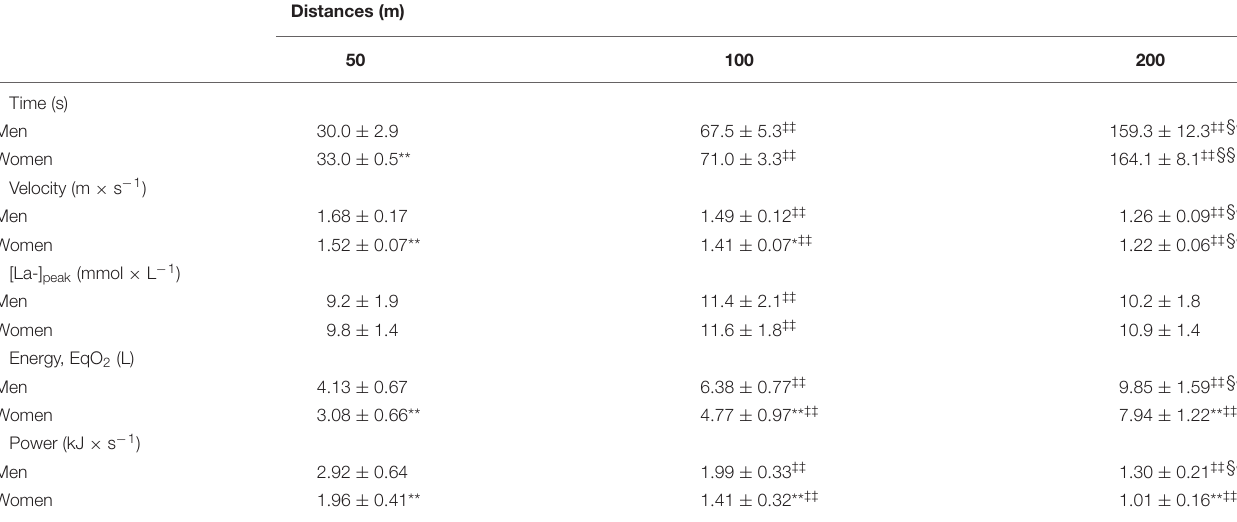
TABLE 1 | Performance and physiological profiles during short and middle distance races.